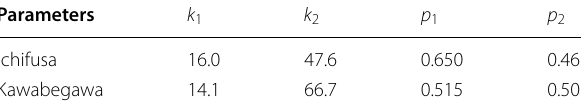
Table 2 Parameter values for SFC Parameters k